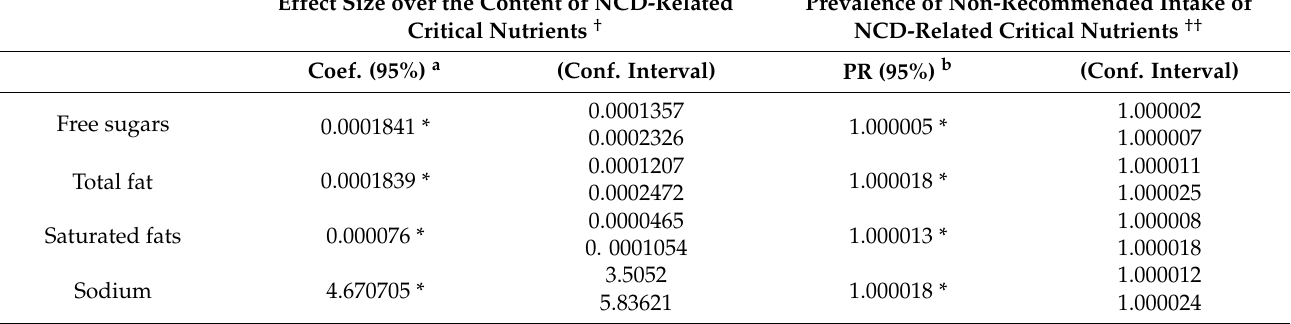
‡ Assessment of dietary intake. School feeding program (PAE), children 4/12 years. Total population estimate: N = 15,070 ( n = 332). 95% CI: 95% confidence interval; NCD: noncommunicable diseases; PAHO-NPM: Pan American Health Organization Nutrient Profile Model. † Content of NCD-related critical nutrients: free sugar, total fat, saturated fat (% of the total energy intake). Sodium content: total sodium (mg) less than the recommended value per age group according to WHO (2000 mg (for adults and adolescents); 1640 mg (for children aged from 5 to 9.9 years old); and 1122 mg (for children aged <5 years old)). Guideline: sodium intake for adults and children, World Health Organization, 2012. †† For free sugar ≥ 10% of total energy intake, for total fat ≥ 30% of total energy intake, for saturated fat ≥ 10% of total energy intake, for sodium ≥ 2000 mg (for adults and adolescents); ≥ 1640 mg (for children aged from 5 to 9.9 years old); ≥ 1122 mg (for children aged <5 years old). Sodium intake recommendation for children were derived from average energy requirements for children with moderate physical activity level, as estimated by FAO/WHO/UNU) Guideline: sodium intake for adults and children, World Health Organization, 2012. a Lineal regression models for free sugar, total fat, saturated fat intake, and linear regression models for sodium adjusted for age groups, sex, education level, and family